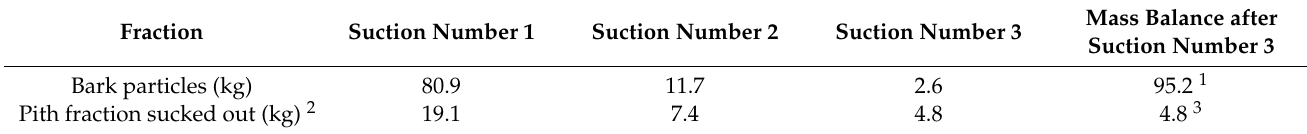
Table 1. Mass balance of the fractionation of 100 kg amaranth stem into bark particles and a sucked fraction containing the pith ones for the three successive suction stages, and mass of the two fractions collected at the end of the separation process. Fraction Bark particles